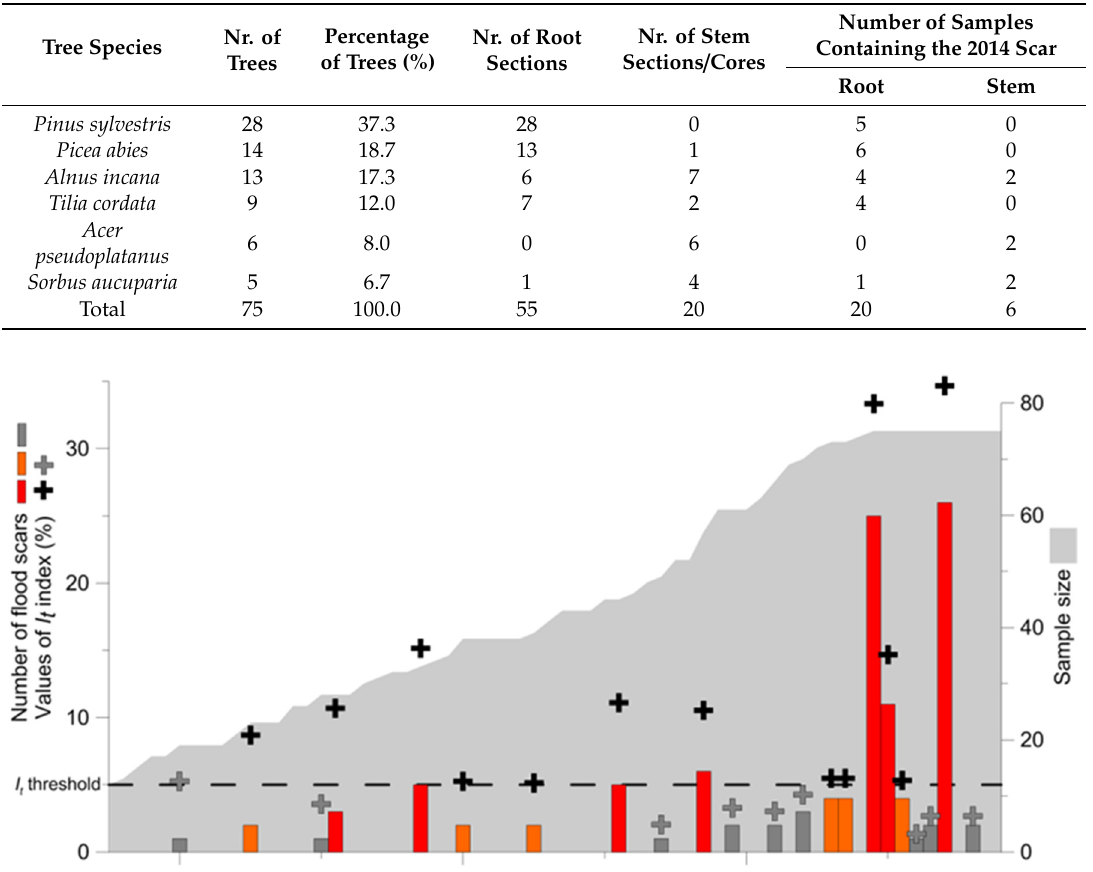
Table 1. Overall number of sampled and dated trees and the distribution of samples containing the 2014 scar.